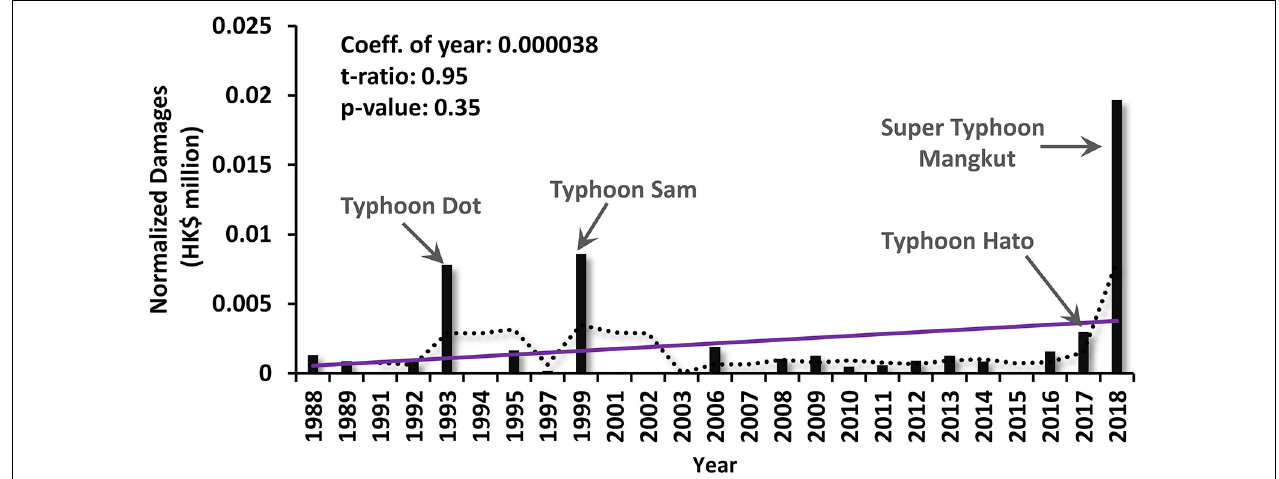
FIGURE 2 | Normalized time series of TC-related damages ( N Dam . ) in Hong Kong. The solid purple line shows the long-term trend (correlation between the series and time). The dotted black line is the 5-year moving average.